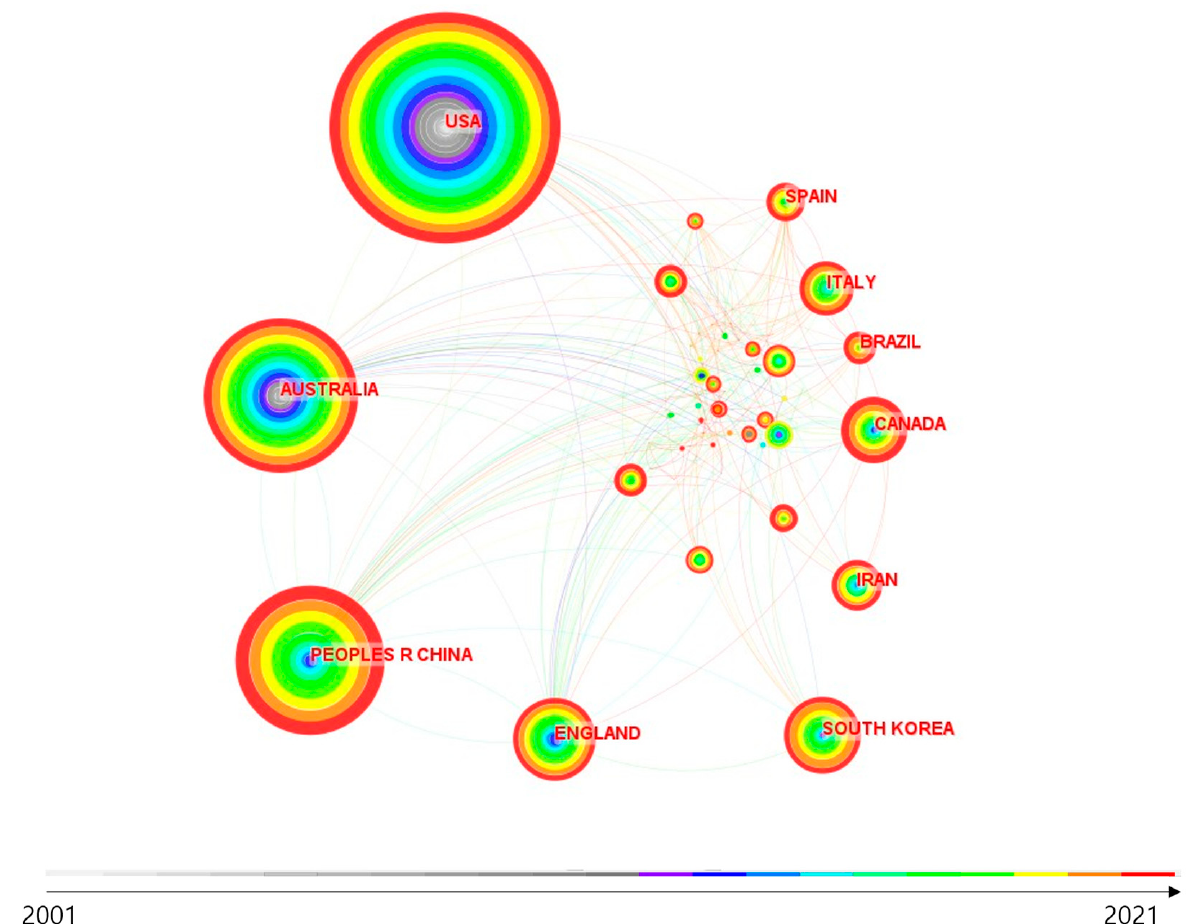
Figure 5. Chronogram cooperation chart for countries employing stormwater runoff management practices.